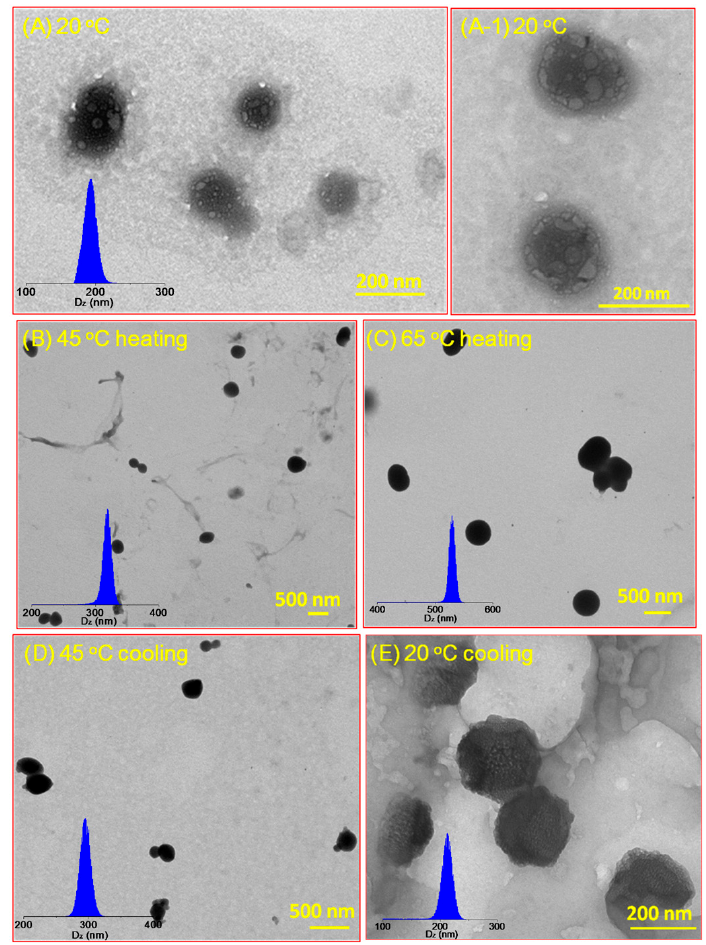
Figure 2. Typical TEM images obtained by drying aqueous solutions of LCHBPNIPAM self-assemblies (0.2 mg/mL) at 20 °C ( A ); 45 °C (heating) ( B ); 65 °C (heating) ( C ); 45 °C (cooling) ( D ); and 20 °C (cooling) ( E ).